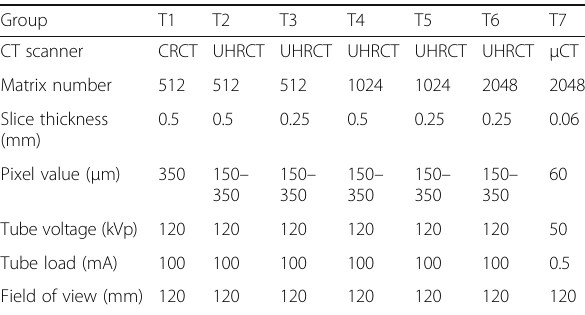
Table 1 Imaging conditions for the seven spatial resolution groups with different CT scanners, matrix numbers, and slice thicknesses for the tiger vertebra